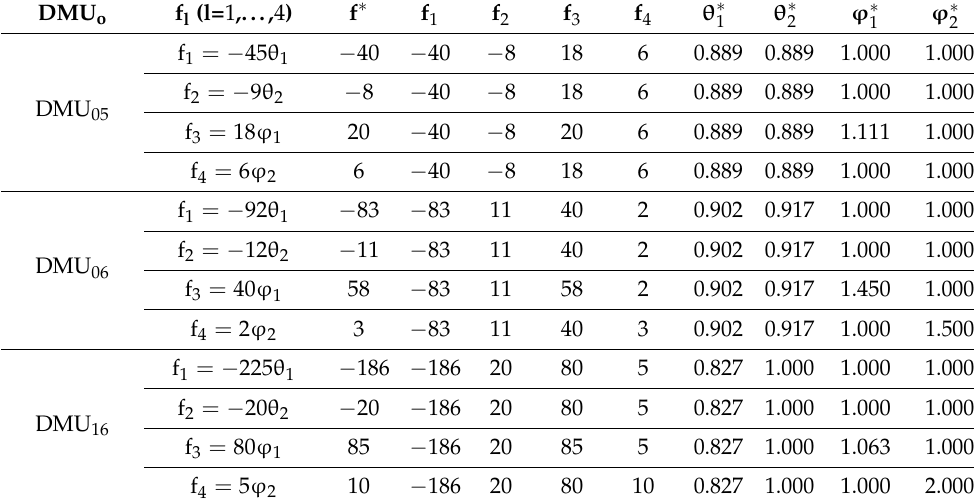
Table 4. The results of solving model 13 for three DMUs (related to the second interactive stage) in the first case study. DMU o f l (l= 1 ,..., 4 ) f ∗ f 1 f